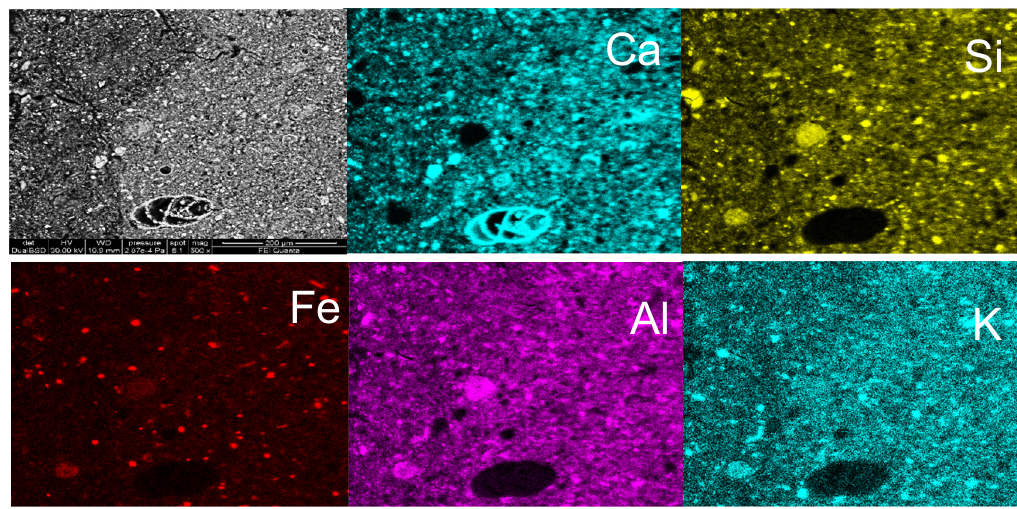
Figure 7. X-ray elemental maps of sample B3, yellow brick (Ca, Si, Fe, Al and K respectively).